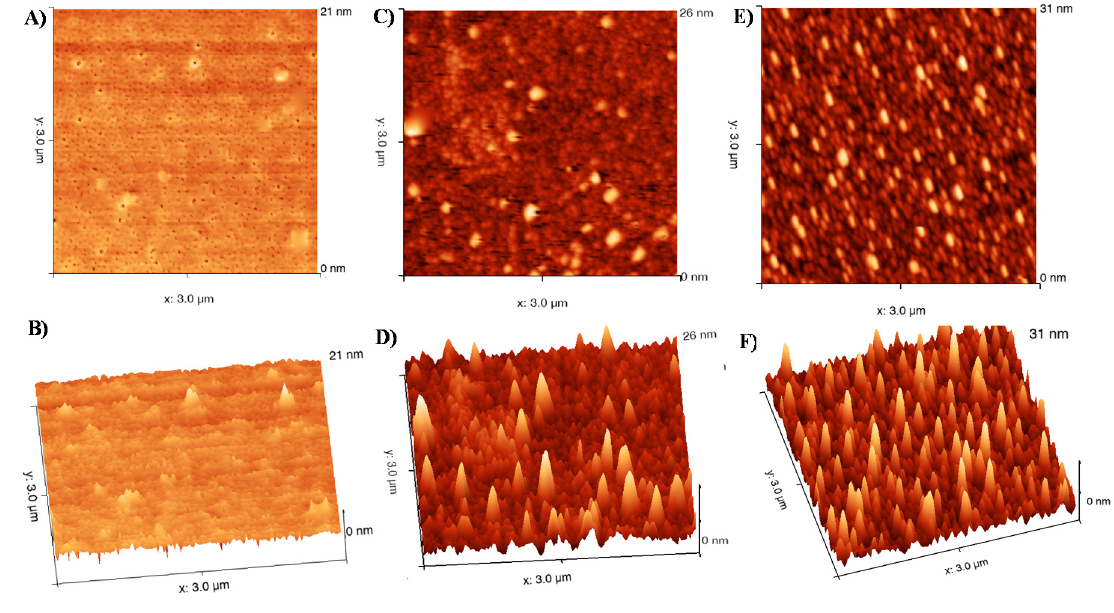
Figure 9. AFM 2D height images (upper part) and 3D topography images (lower part) of neutravidin immobilization ( A , B ), DNA surface probe capture ( C , D ), and target DNA binding at 2 µM concentration ( E , F ). 2 µ M concentration ( E , F